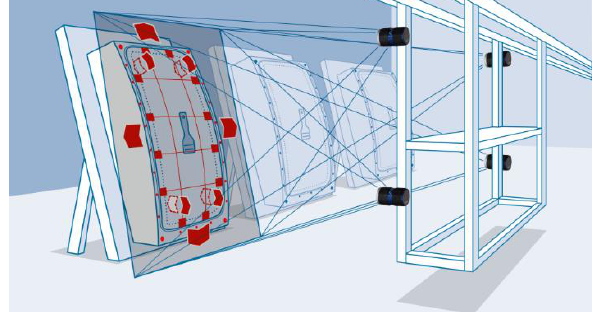
Figure 18: Online measurement during door adjustment